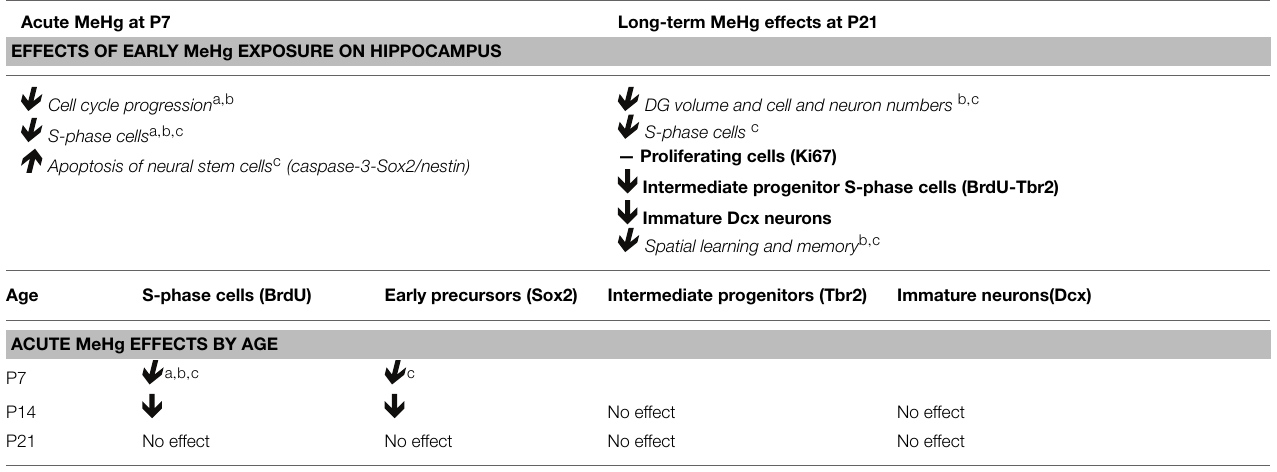
TABLE 1 | Summary of previous and current